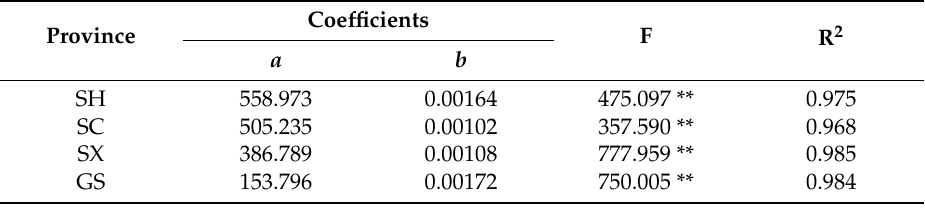
Table 8. Fitting results for the function of annual gross benefits from electricity utilization.